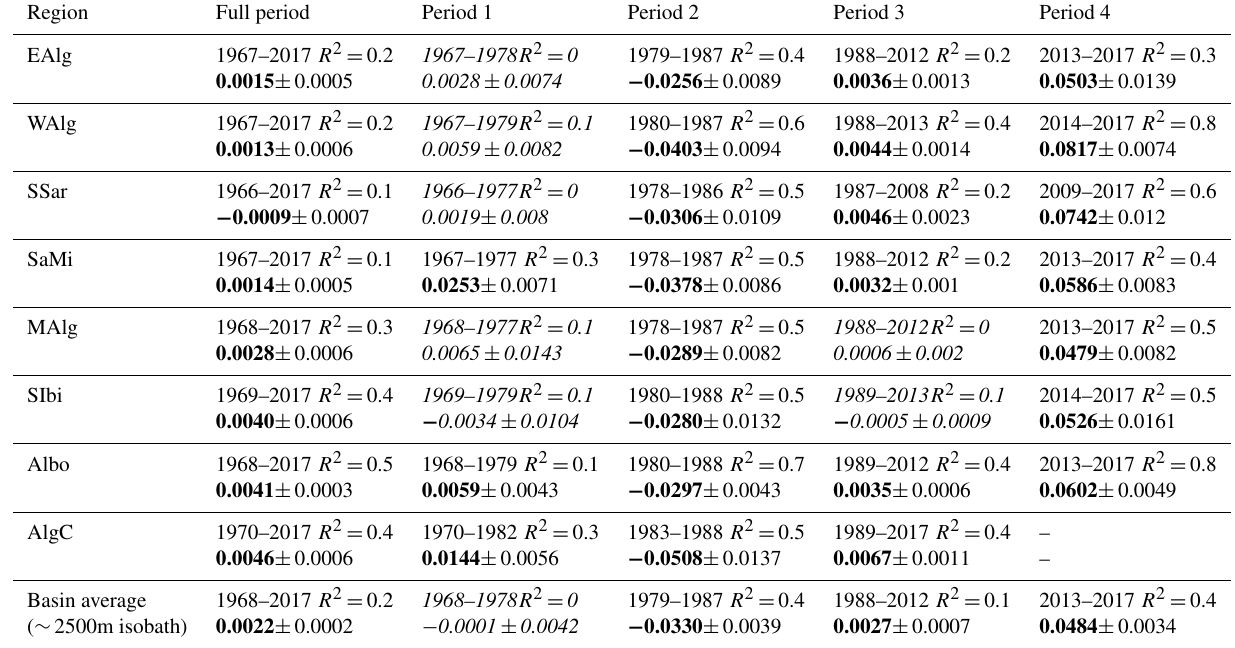
Table 1. Evolution of LIW potential temperature during different periods of time from 1960 to 2017 (expressed in mean trend ± the half width of the 95% confidence interval ◦ Cyr − 1 ). The period slightly differs from one area to another, to best track the identified patterns. The coefficient of determination ( R 2 ) is indicated; the statistically significant regressions ( P value < 0.05) are indicated in bold; the nonstatisti- cally significant regressions ( P value > 0.05) are indicated in italic.